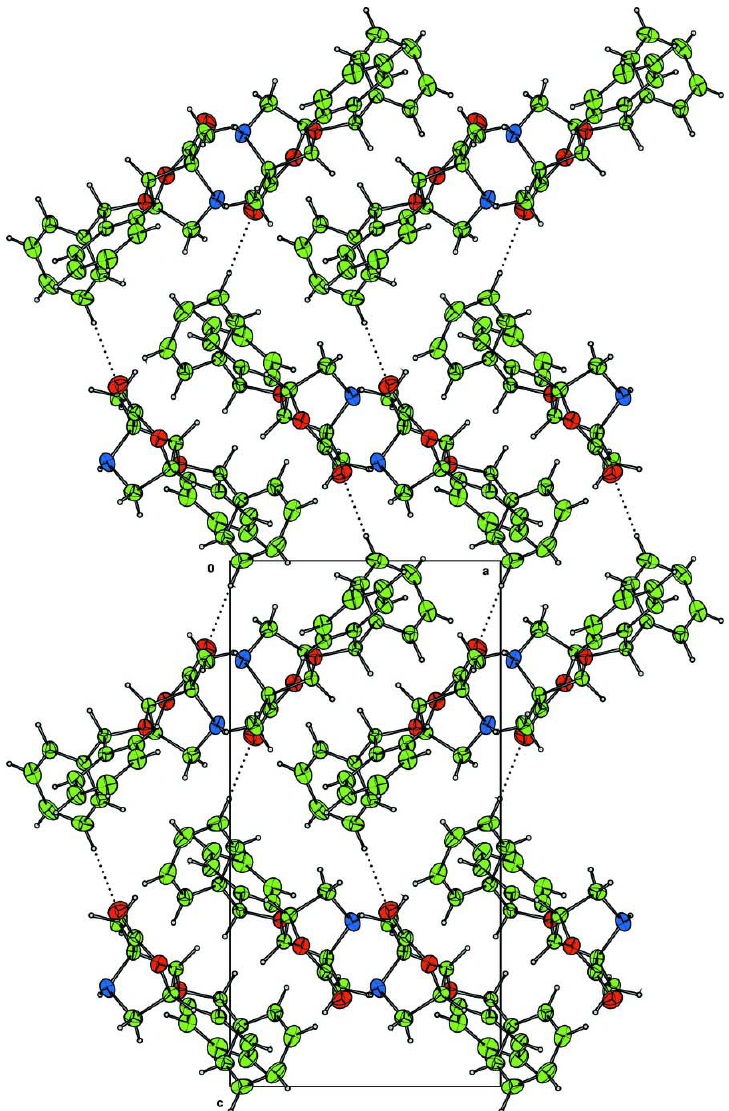
Packing diagram showing hydrogen bonded chains running parallel to the a -axis.